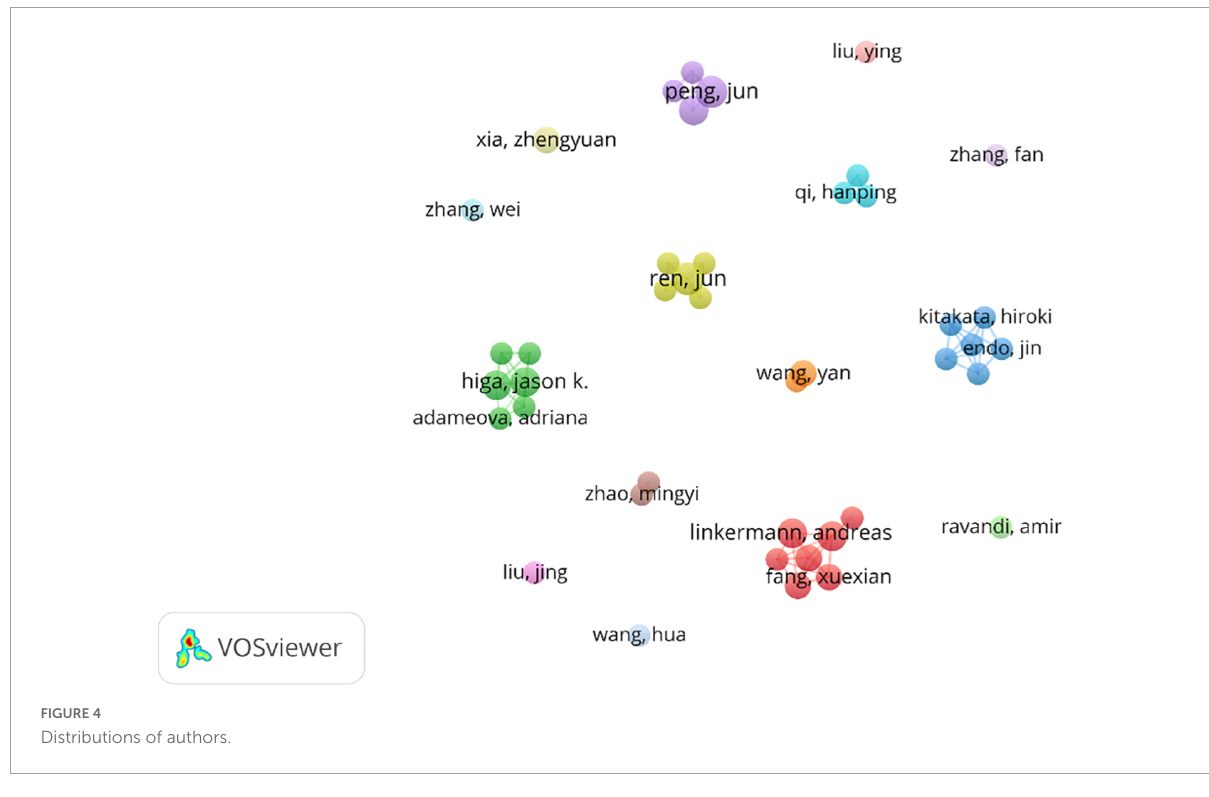
TABLE 4 Top 10 journals of ferroptosis in cardiovascular